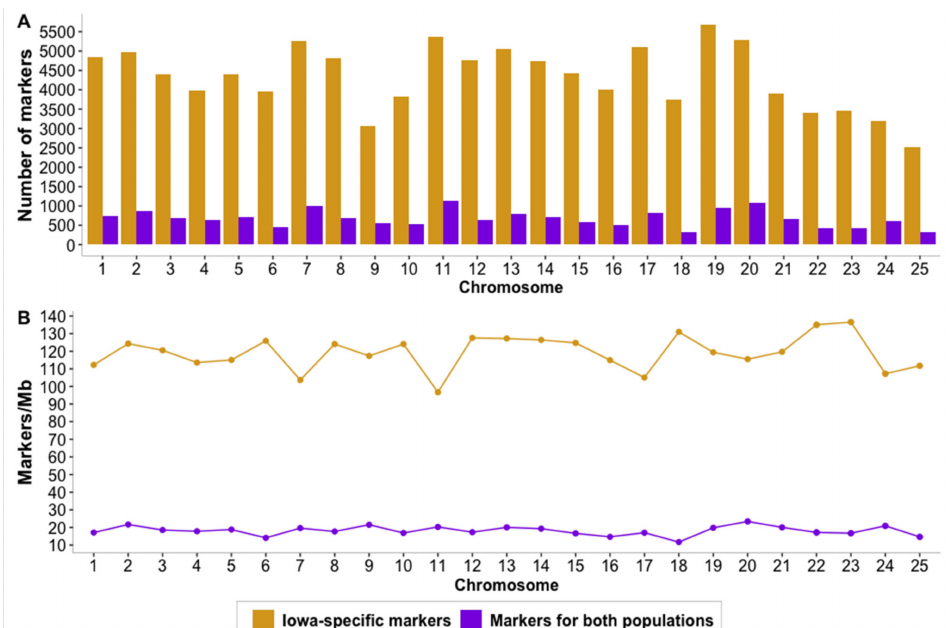
Figure 3. Distribution of single nucleotide polymorphisms (SNPs) by chromosome. ( A ). Average number of population- specific SNPs for the Iowan (yellow) and for both populations combined (purple). ( B ). Average density of population-specific SNPs per chromosome for Iowan (yellow) and for both populations combined (purple).